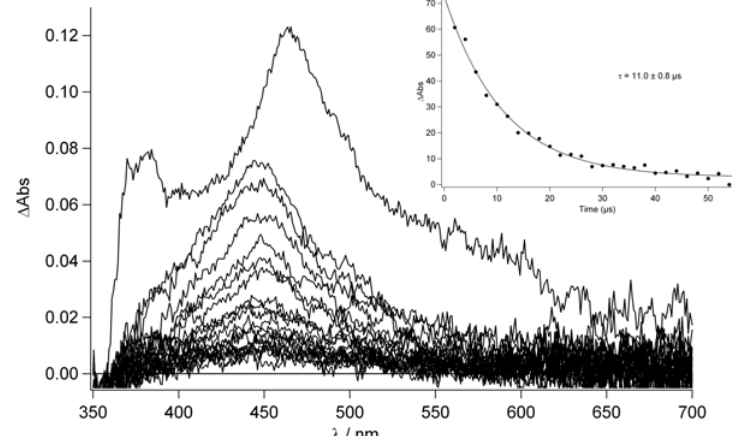
Figure 9. Nanosecond transient absorption spectrum for TpyPhPyrene acetonitrile with 2 µs incremental time delay (  decay is depicted in the